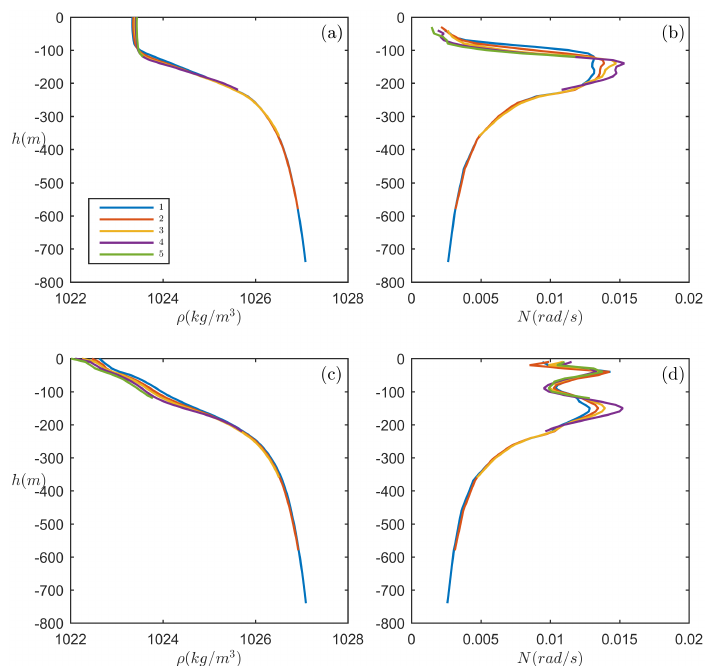
Figure 8. Background density and buoyancy frequency distribution along the transect of the North West Shelf case. ( a , b ) are situations in summer, while ( c , d ) are in winter. Five different lines in each panel represent situations on the chosen five points along the wave propagation transect.